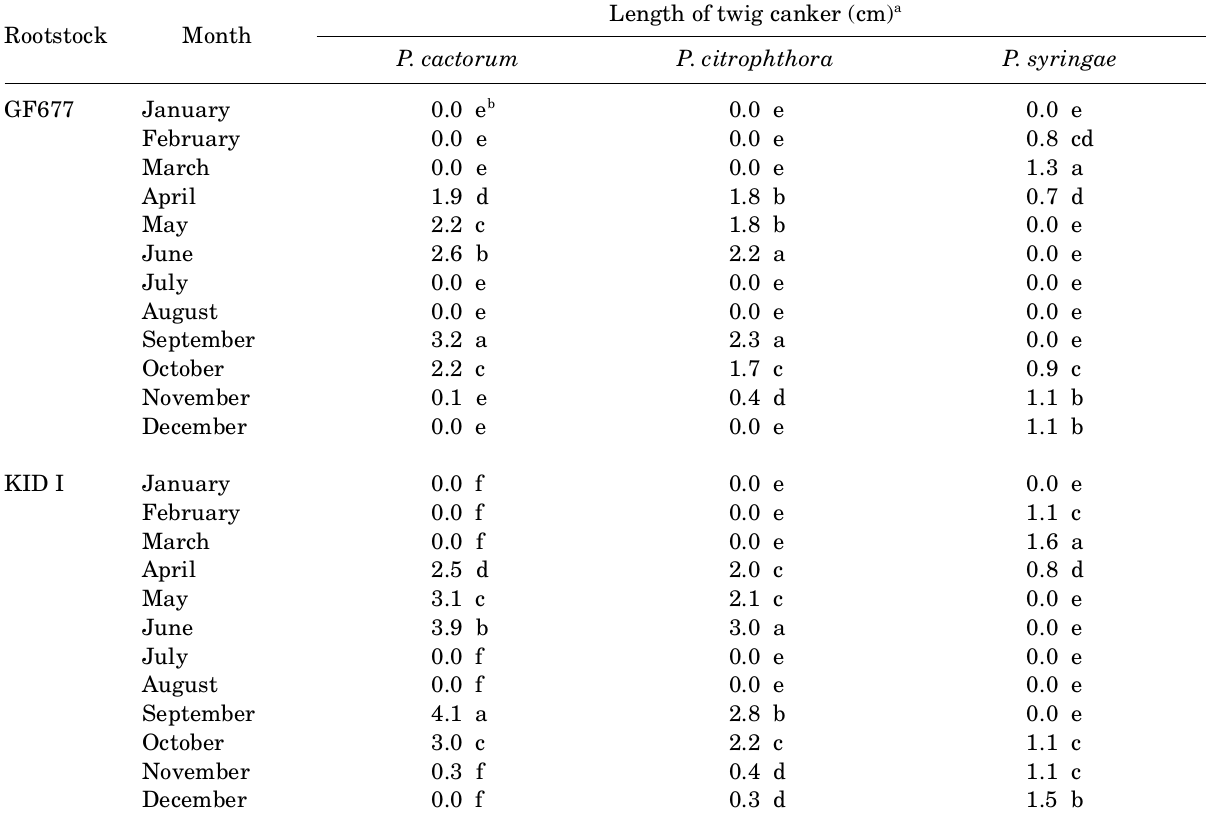
Table 1. Development of twig cankers on shoot segments of peach rootstocks GF677 (A) and KID I (B) inoculated with Phytophthora cactorum , P. citrophthora and P. syringae. Length of twig canker (cm) a Rootstock Month P. cactorum P. citrophthora P.